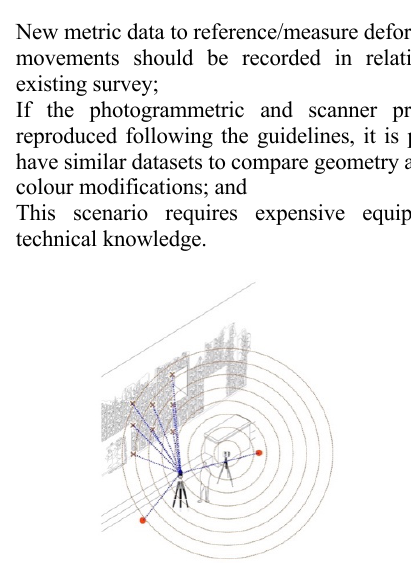
Figure 20 . Scenario 3: Comprehensive Digital Documentation with Photogrammetry, 3D Laser Scanning, and REDM Total Station. Image by CIMS © GCI